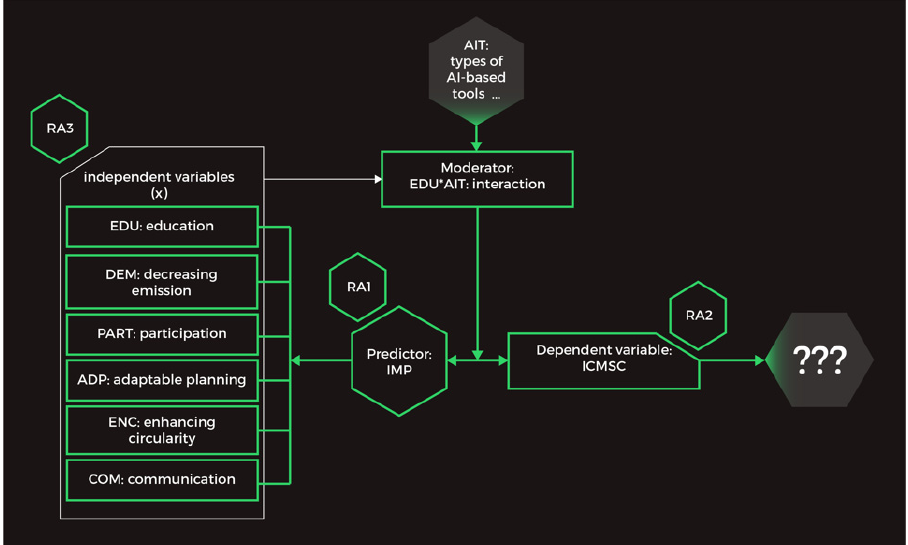
Figure 5. The initial assumptions for building the model. Authors’ own elaboration.